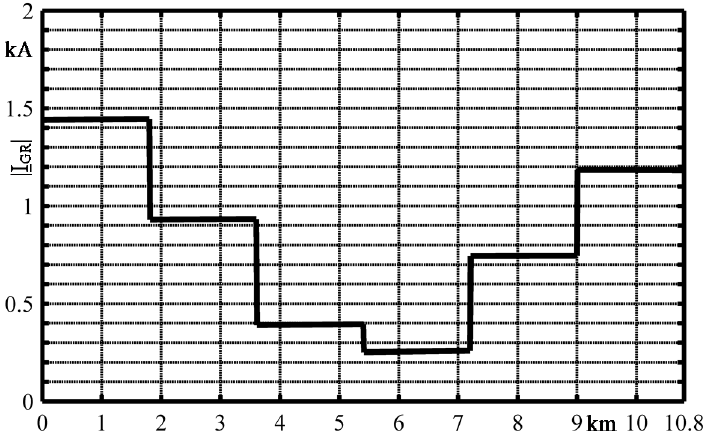
Figure 11. Faulted double-circuit UGC: ground return current magnitudes along the line (CB with PTs); FAULT at midline.